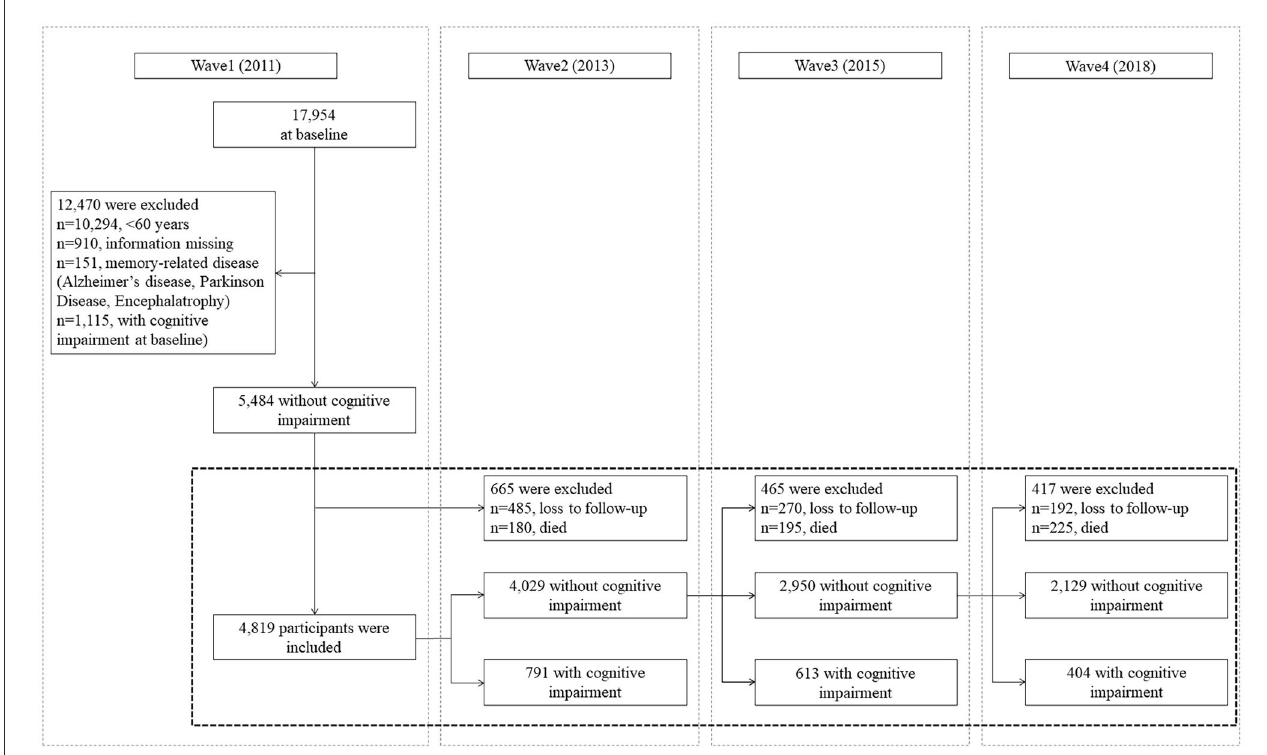
FIGURE1 Sample selection flowchart based on the 2011–2018 China Health and Retirement Longitudinal Study (CHARLS) data.